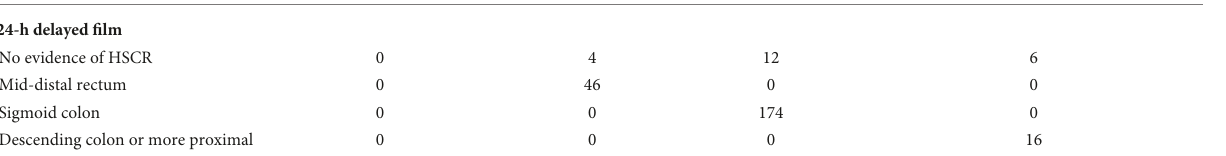
TABLE 3 Correlation between the 24-h delayed film of barium enema and pathological results in different clinical types of HSCR.